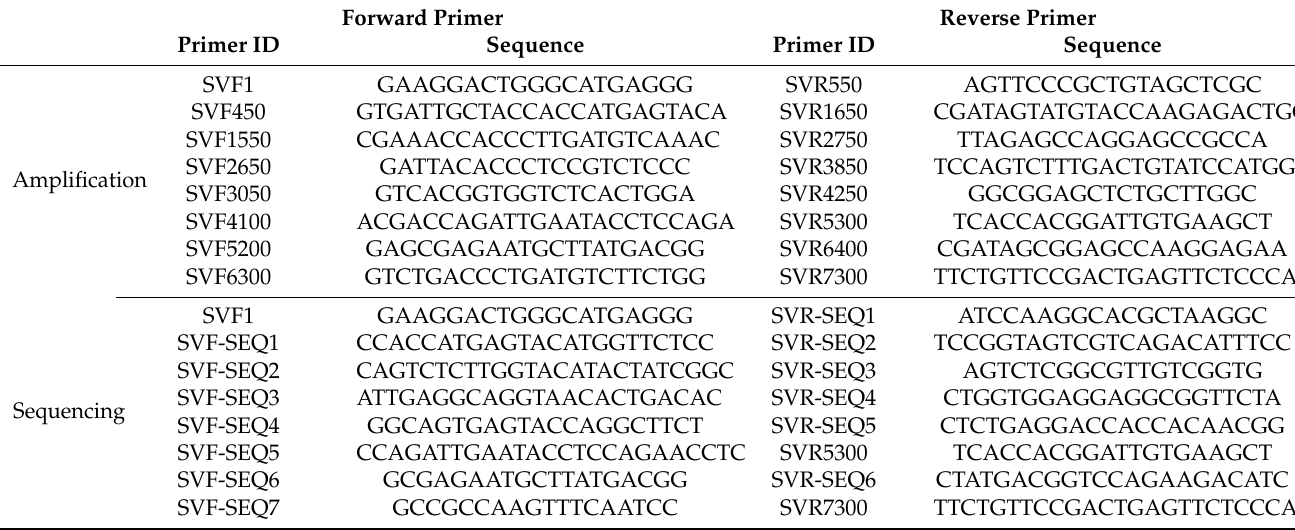
Table 1. Primers utilized for amplification and sequencing of isolated